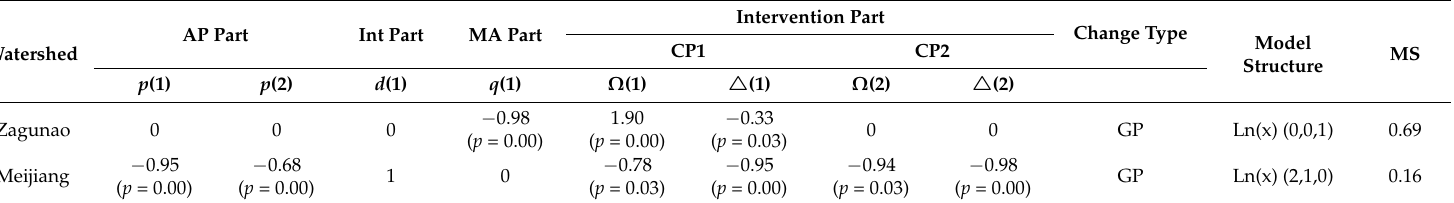
Figure 5. Modified double mass curves in ( a ) the Zagunao and ( b ) the Meijiang watersheds. Table 4. ARIMA Intervention models for the slope of MDMC.